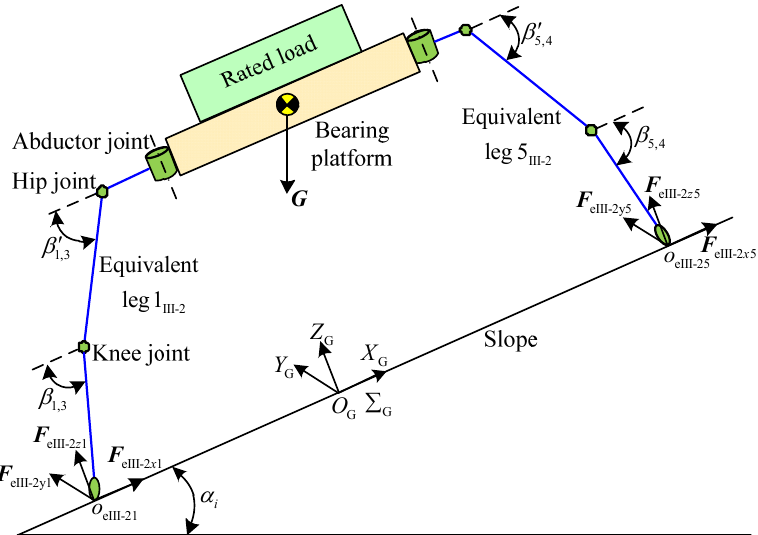
Figure 19. Equivalent model of support phase under working condition III ‐ 2.